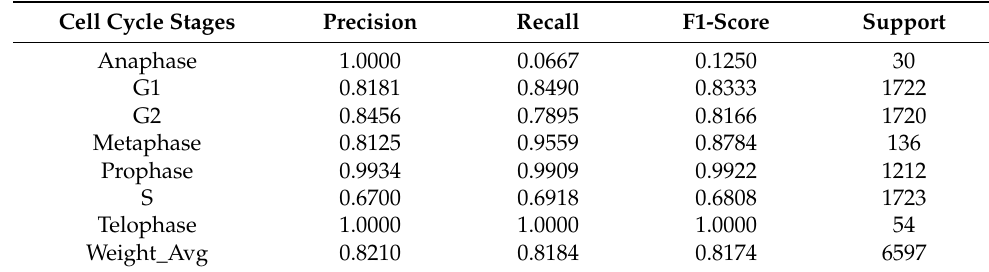
Table 6. The seven-stage classification results for images generated by WGAN-GP.